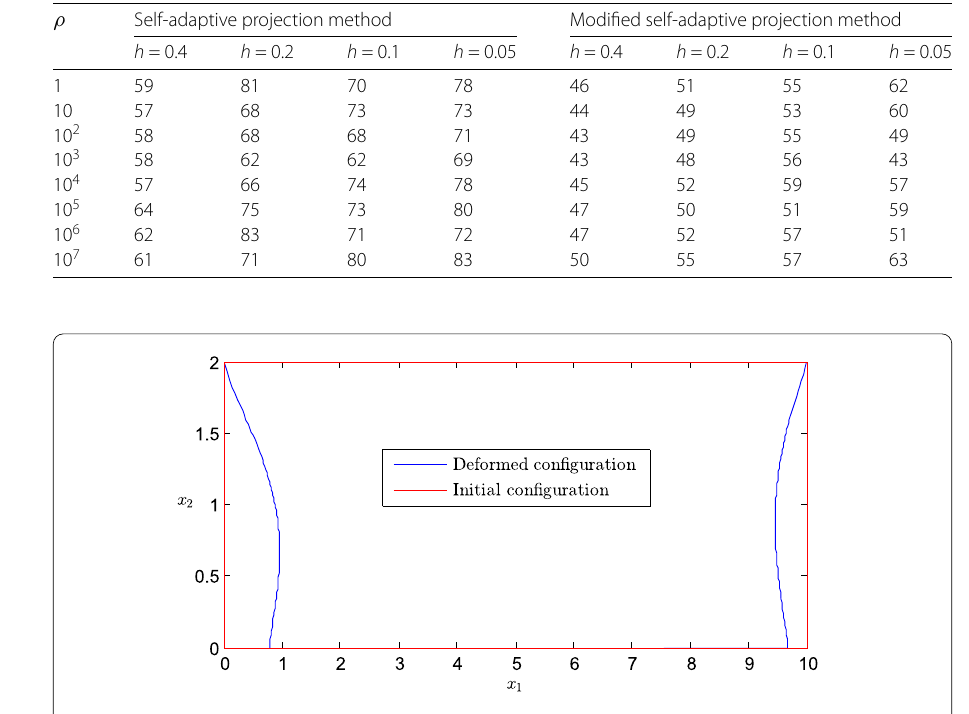
Figure 4 Initial and deformed configurations